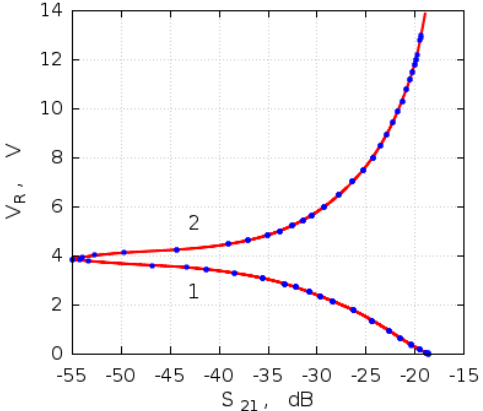
Figure 6: Calibration curve recovered from the data in Fig. 5 (branches 1 and 2 correspond to weak and strong light, respectively, dots show the measured values, and the curve is the smooth fit needed for data processing).